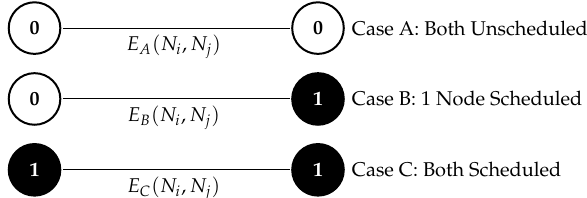
and , respectively. N i and N j represent 1 0 | (cid:105) | (cid:105)